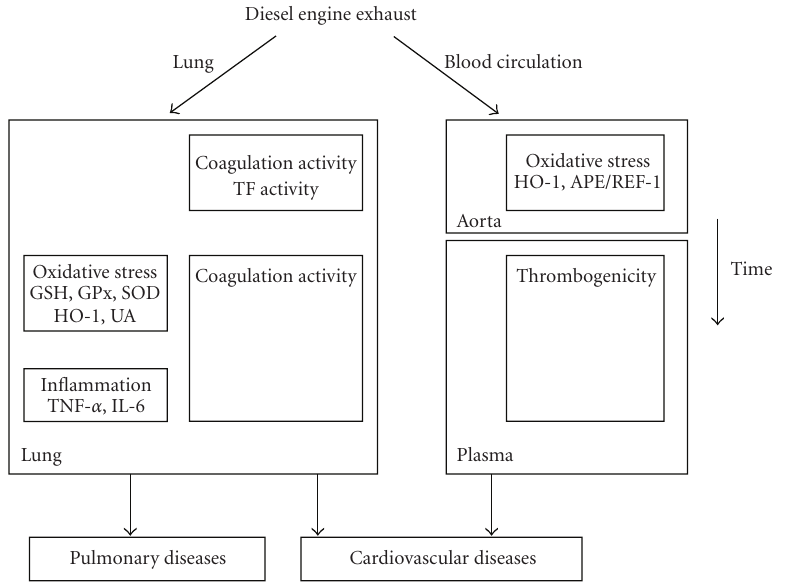
Figure 3: Hypothetical mechanism of the e ff ect of diesel engine exhaust on the cardiopulmonary system.